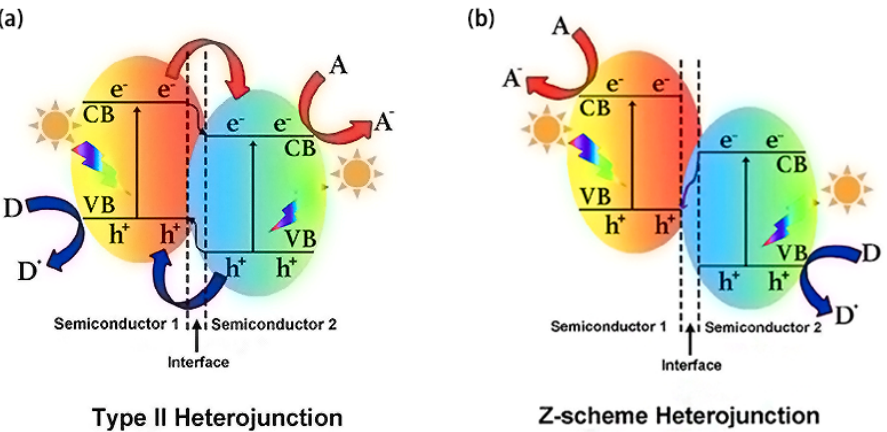
Figure 5. Band structure of ( a ) type II and ( b ) Z − scheme heterojunctions. “A” and “D” represent electron acceptor and electron donor, respectively. Used with permission from [100]. Copyright 2016 American Chemical